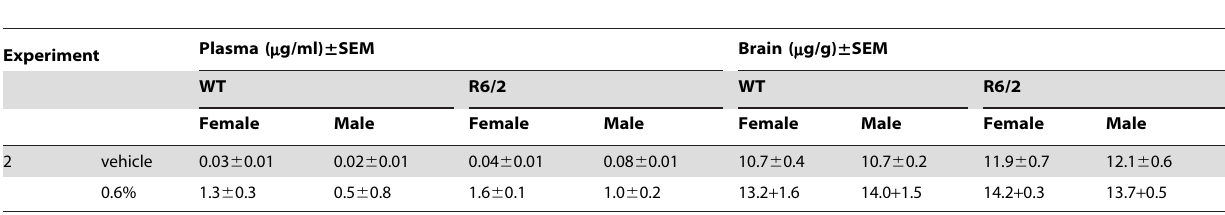
Plasma : Both R6/2 and WT treated mice had higher levels than untreated mice. Treatment main effect: F(1,16)=173.5, p , 0.0001). Treated, but not untreated, mutant mice had higher plasma levels than WT mice (genotype main effect: F(1,16)=6.1, p , 0.026; genotype 6 treatment interaction: F(1,16)=6.0, p , 0.02, simple main effects: p , 0.05). Levels were higher in females than male mice (gender main effect: F(1,16)=15.7, ps , 0.02). Brain : CoQ10 levels in animals receiving 0.6% CoQ10 were higher than those of untreated mice, independent of gender and genotype (treatment main effect: F(1,16)=15.8, p ,